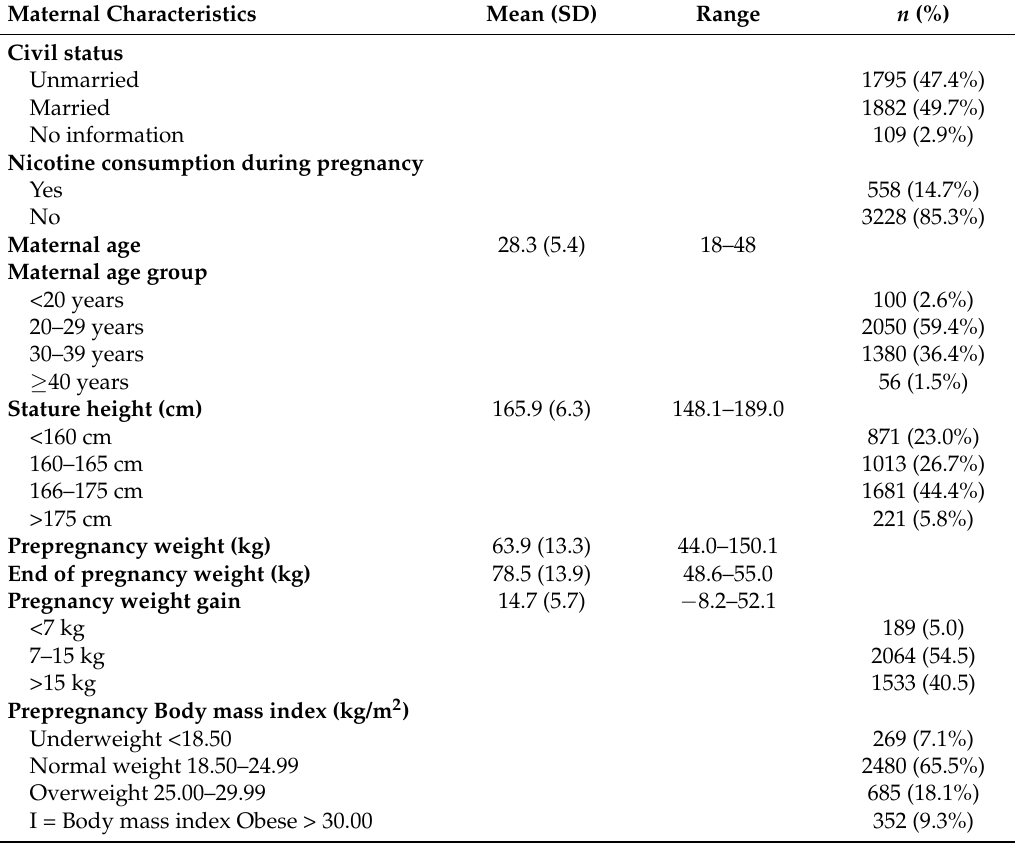
Table 1. Maternal sample characteristics, absolute and relative